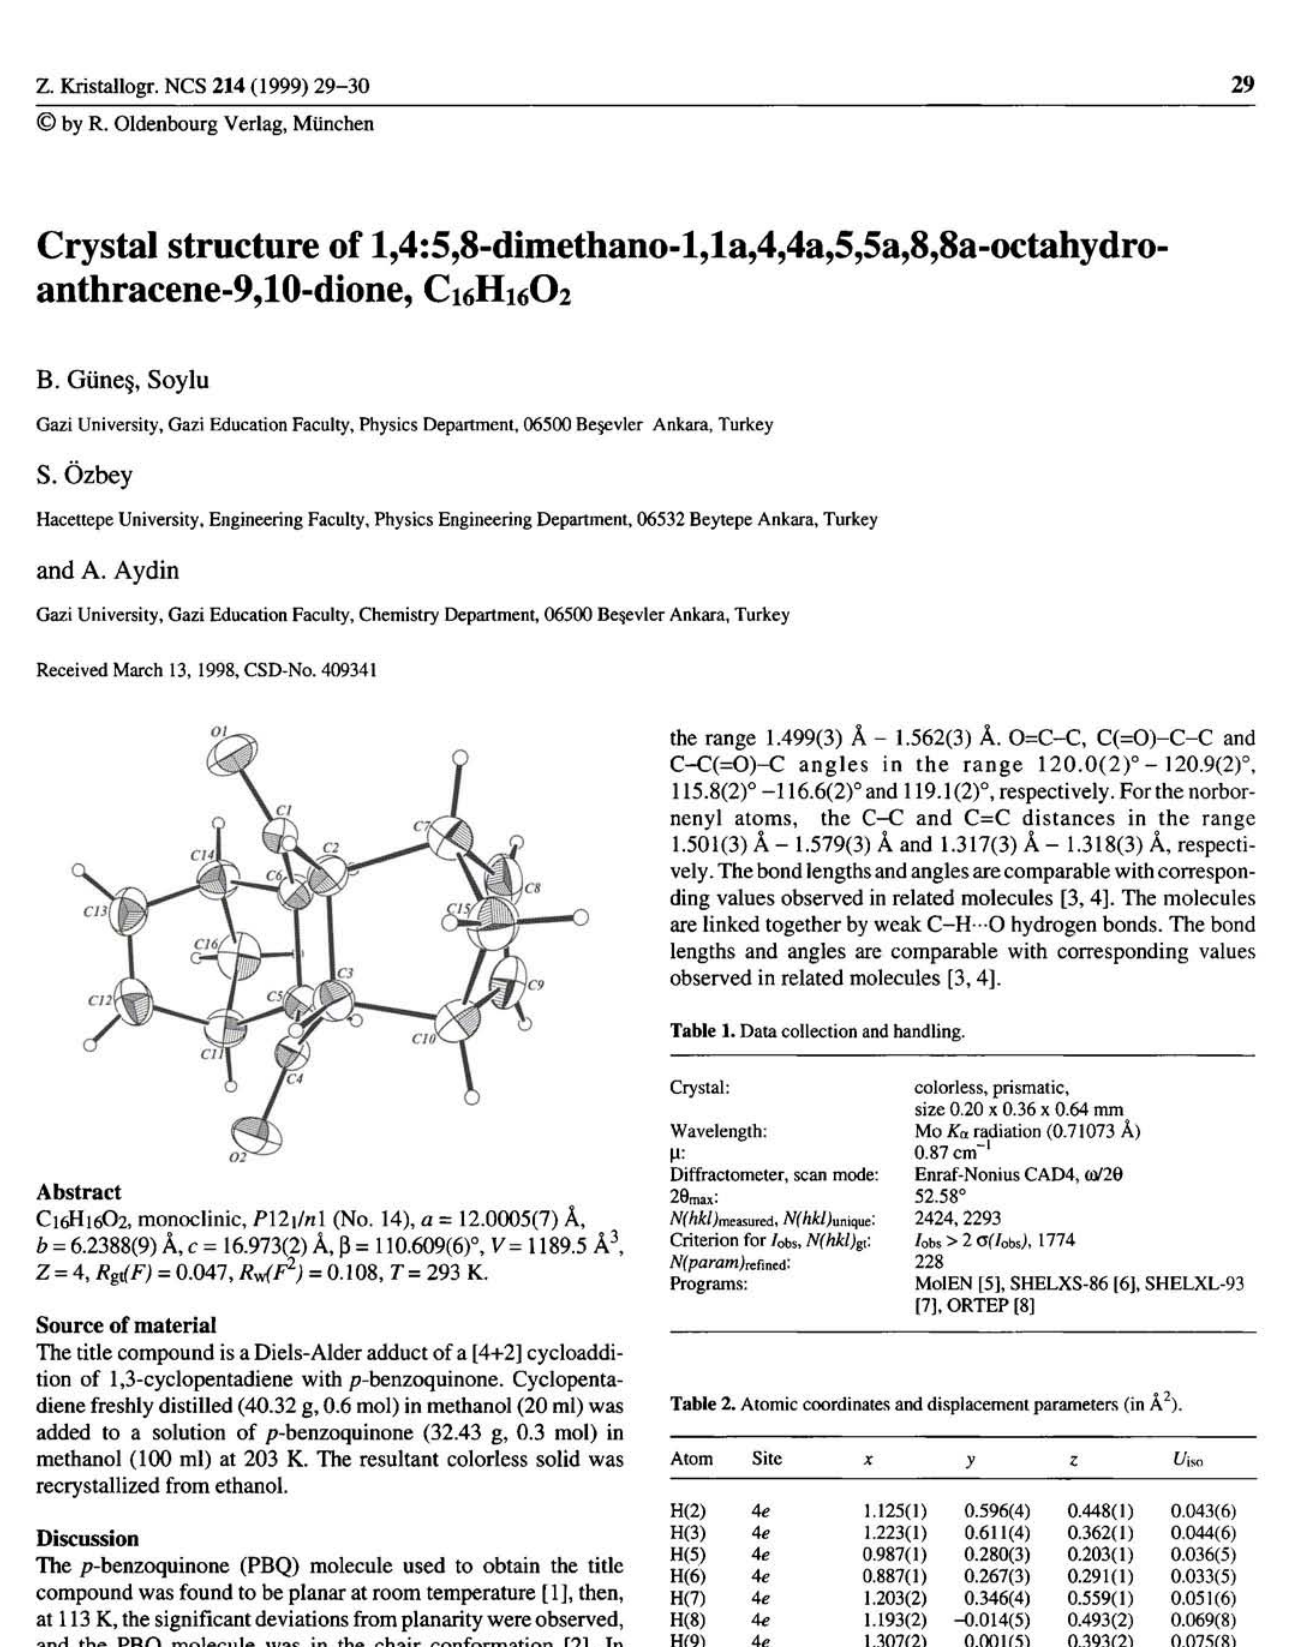
Table 2. Atomic coordinates and displacement parameters (in A 2